Question: What style of plot is this figure drawn as?
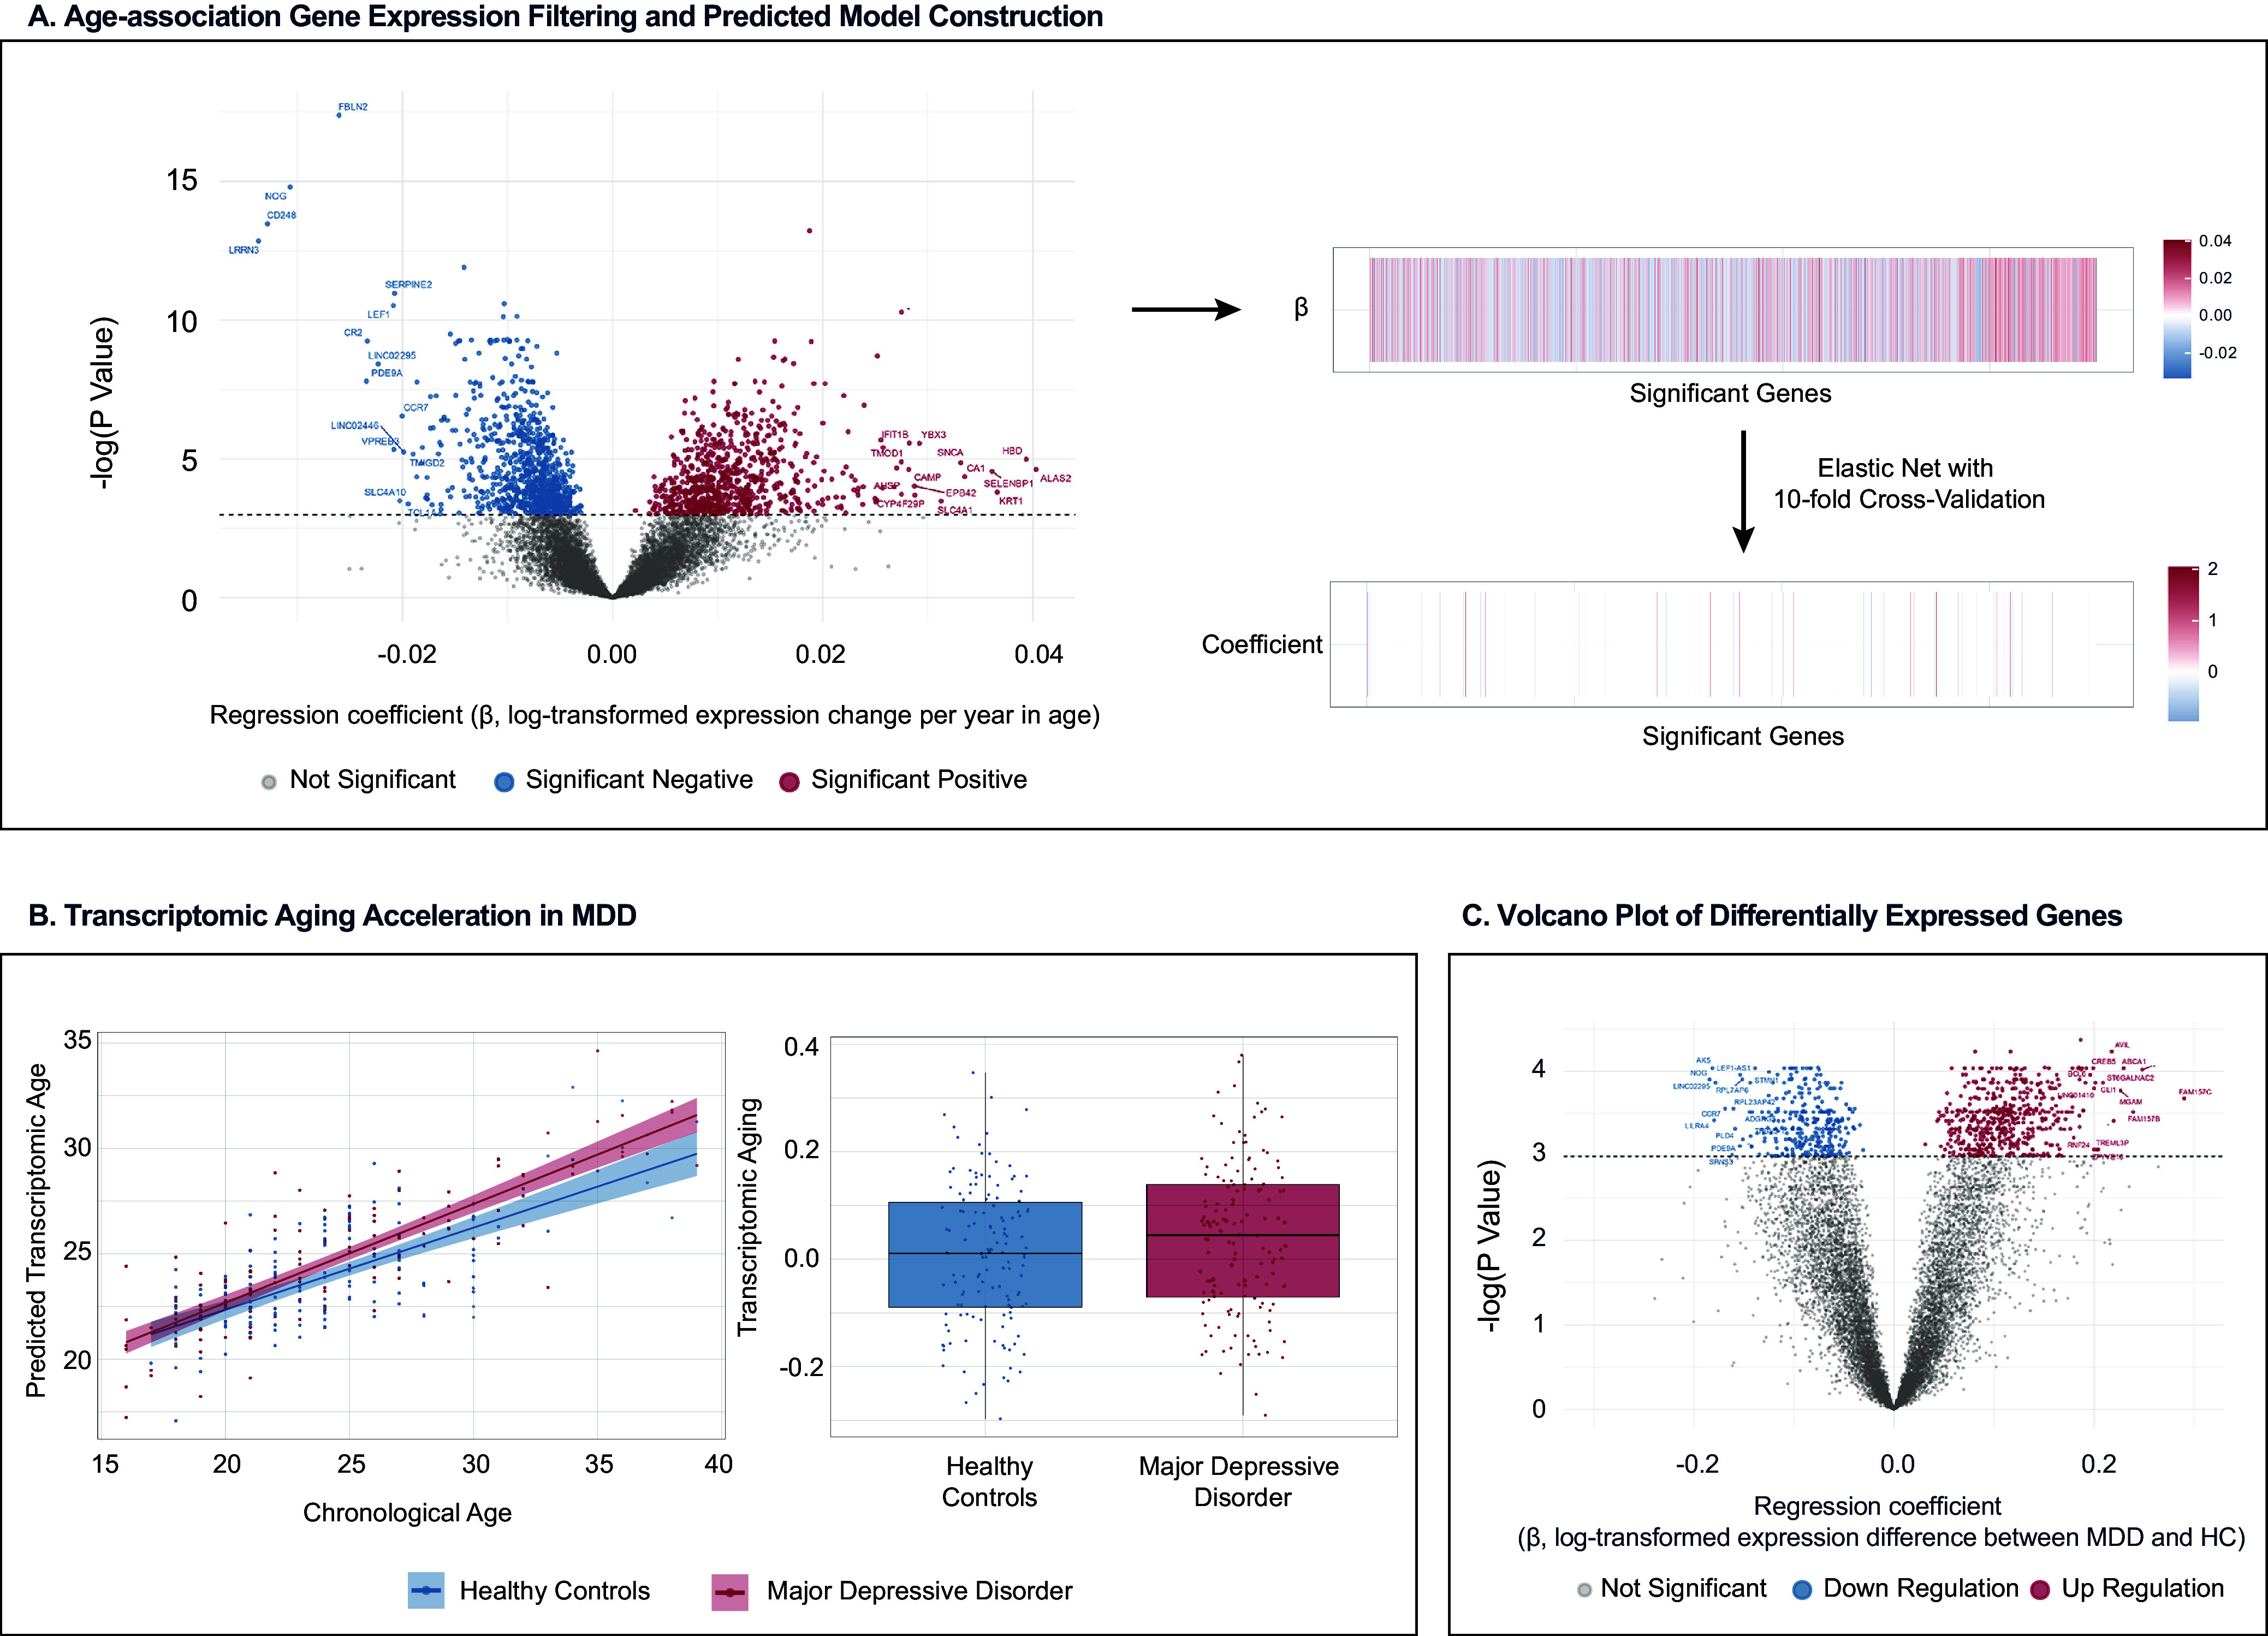
Answer: box